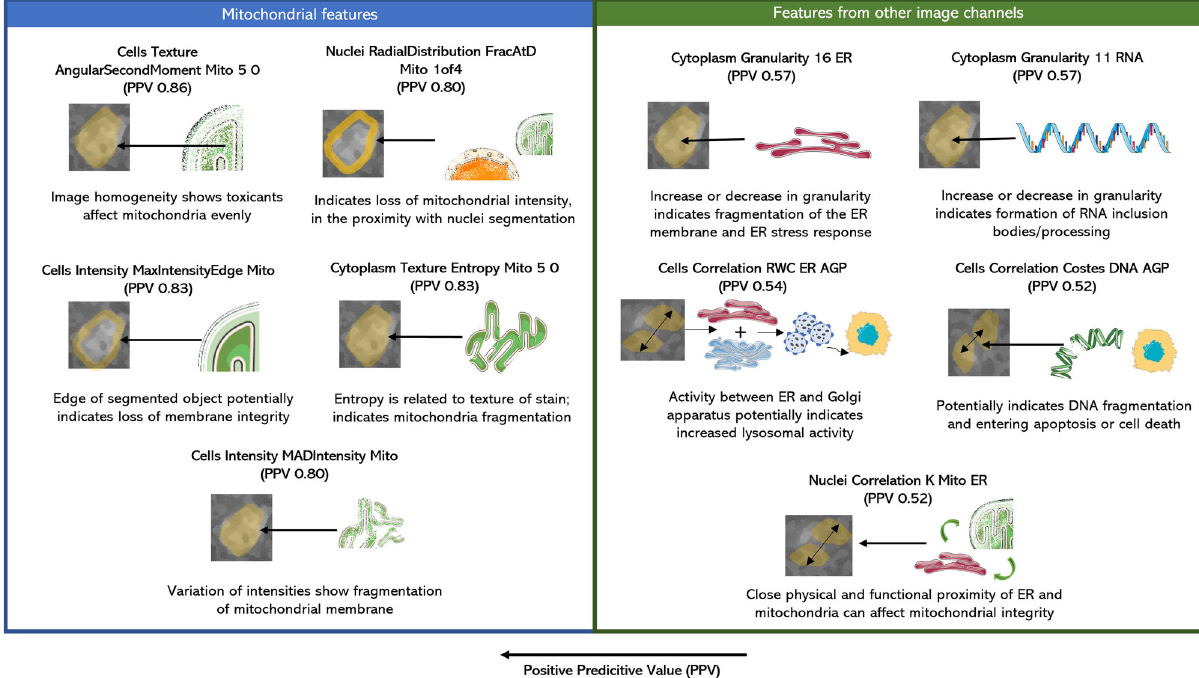
Fig. 6 Biological implication of Cell Painting features in relation to mitochondrial toxicity. Biological implication of mitochondrial toxicity translated from the computational image statistics of Cell Painting features. Features were mainly related to edge intensity of cells (possibly related to integrity of cell wall), radial distribution and intensity in mitochondria (related to mitochondrial death) and granularity features (related to cell death and amount of information contained in cellular images). Further details in Supplementary Data 4. AGP Actin Golgi Plasma membrane, DNA Deoxyribonucleic acid, ER endoplasmic reticulum, Mito Mitochondria, RNA Ribonucleic acid. The Figure was partly generated using Servier Medical Art, provided by Servier, licensed under a Creative Commons Attribution 3.0 unported